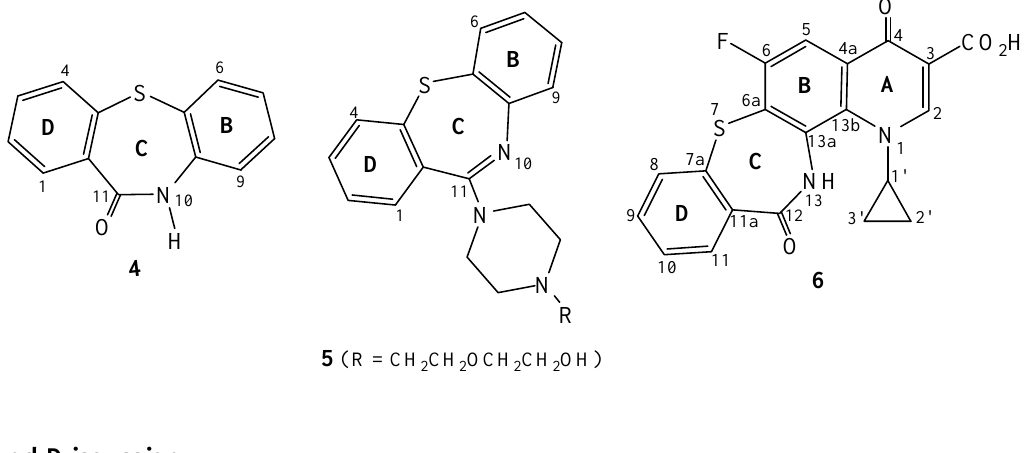
Figure 2 . Structures of dibenzo[ b , f ][1,4]thiazepine-11(10 H )-ones 4 , quetiapine 5